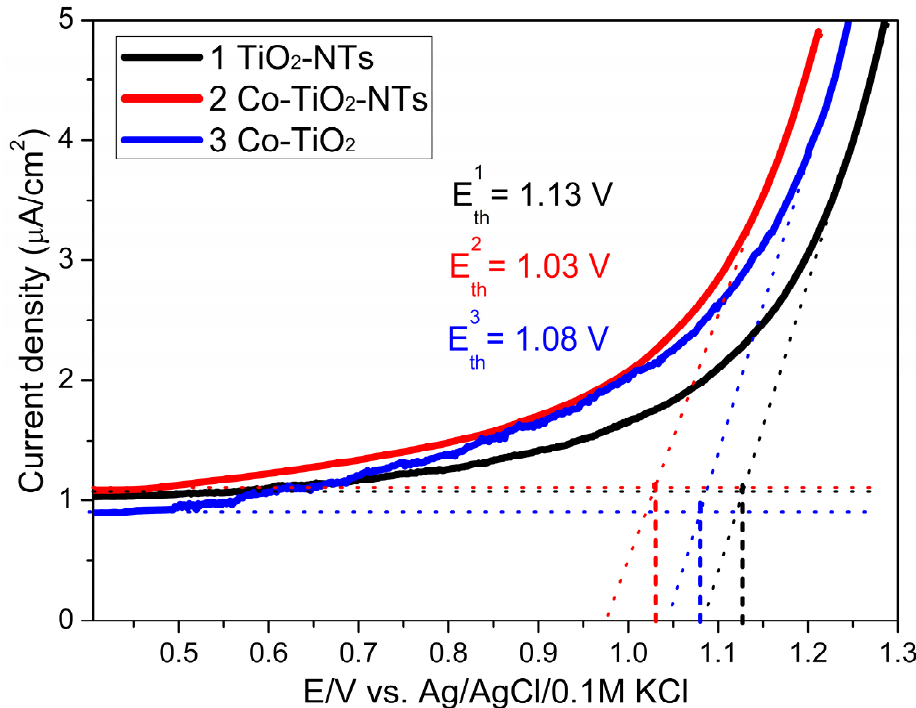
Figure 6. Linear sweep voltammetry (LSV) curves obtained for samples TiO 2 -NTs, Co-TiO 2 -NTs, and Co-TiO 2 , used for the evaluation of the water oxidation threshold potential E th , sweep rate 50 mV·s − 1 .